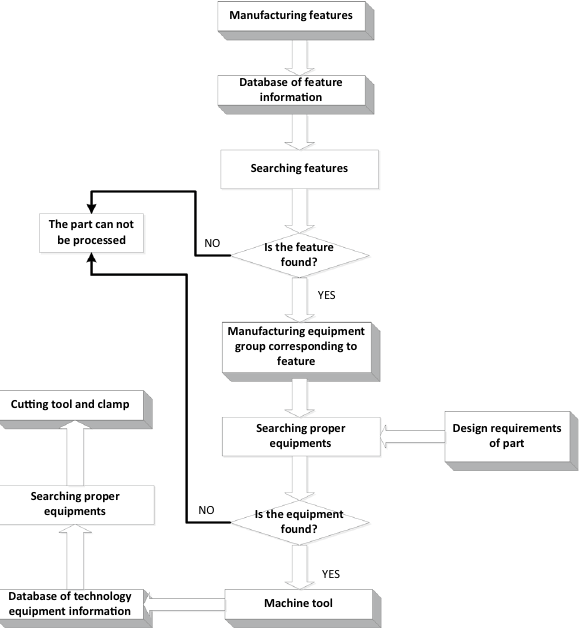
Figure 8. Manufacturability evaluation based on manufacturing resources